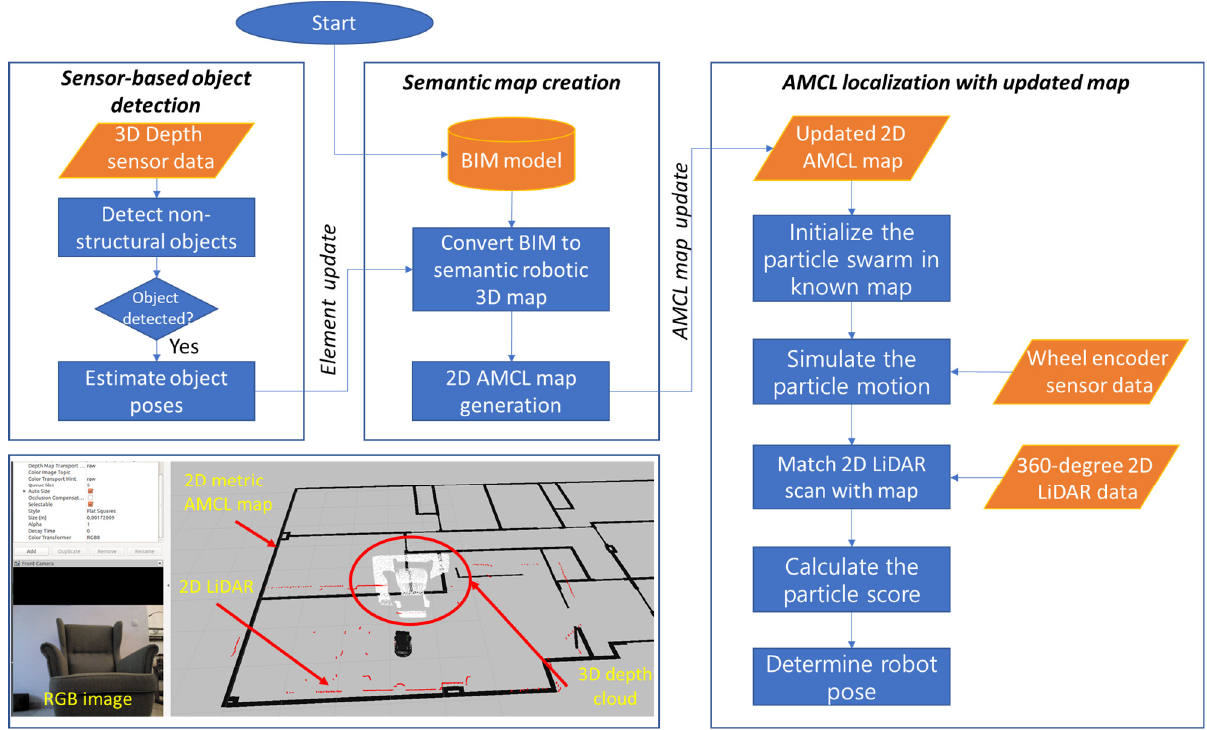
Figure 1. Overall framework.